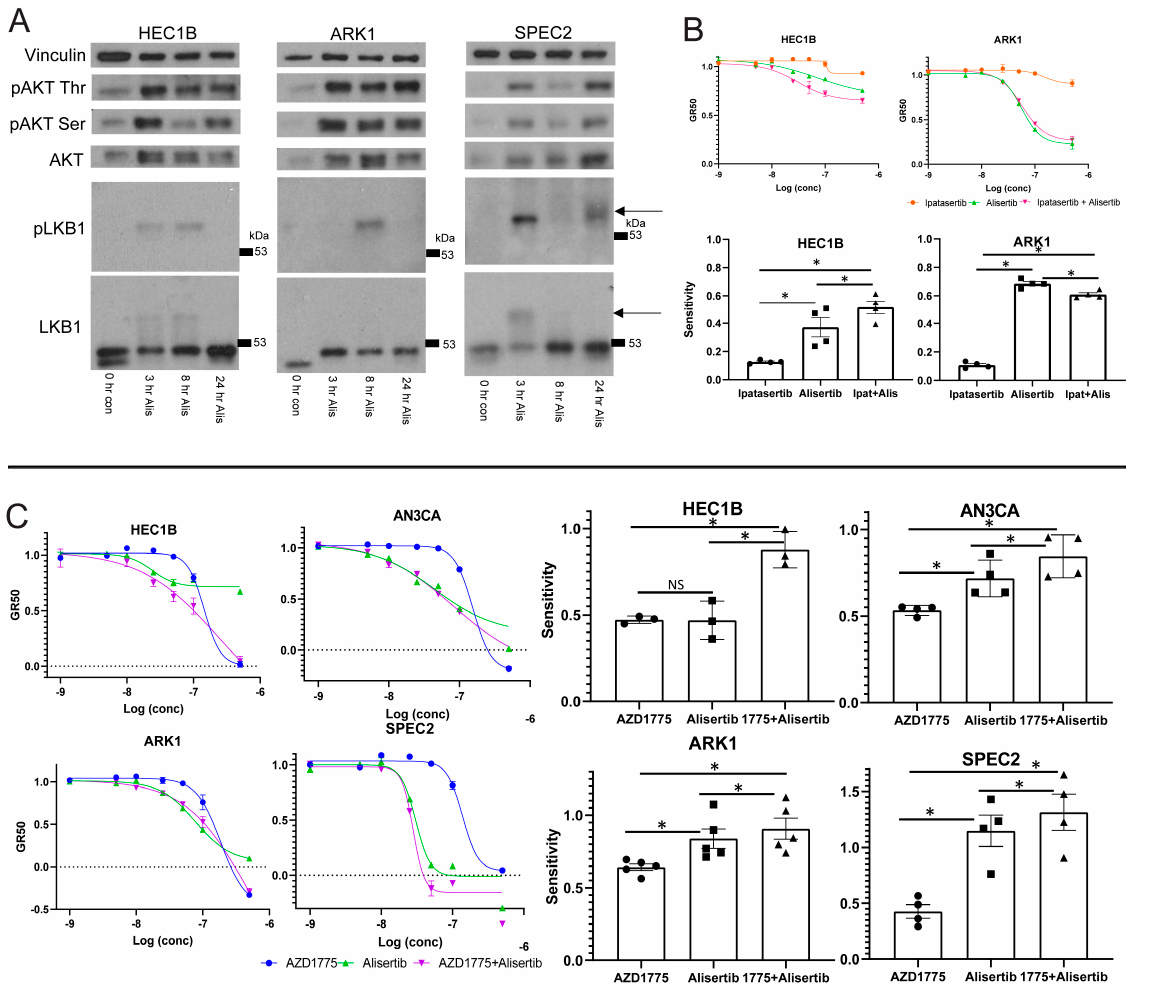
Figure 4. Combining Aurora kinase and WEE1 kinase inhibitors overcomes Aurora kinase inhibitor resistance. ( A ) Cell lines were treated with 0.25 uM Alisertib (Alis) over a 24 h period compared to a 0 h untreated control (con), and lysates were prepared from cells harvested at 3, 8, and 24 h post-treatment and analyzed for LKB1 and AKT expression and modification (AKT phosphorylated on Serine 473 (pAKT Ser) or Threonine 308 (pAKT Thr) and LKB1 phosphorylated on Serine 428 (pLKB1)). In the LKB1 and pLKB1 blots, an arrow indicates the higher molecular weight phosphorylated band. ( B ) An Alisertib resistant (HEC1B) and sensitive (ARK1) cell line was treated with either Alisertib, Ipatasertib, or a combination of Alisertib and Ipatasertib (Ipat + Alis). Representative growth rate corrected dose curves are shown for each line on the left, and sensitivity (area over the growth rate corrected dose curve) is shown on the right for each line with each treatment. Bars represent the average of four replicates, and error bars represent the standard error of the mean. p -values were calculated using both a two-way ANOVA test and a paired t -test comparing different single treatments to the combination or each other. * p < 0.05 for both tests. Comparisons are indicated by a horizontal line over the bars for the treatments being compared (Alisertib vs. Ipatasertib, Alisertib vs. Ipatasertib+Alisertib, and Ipatasertib vs. Ipatasertib+Alisertib). ( C ) An Alisertib resistant (HEC1B) and three sensitive (ARK1, SPEC2, AN3CA) cell lines were treated with either Alisertib, AZD1775, or a combination of Alisertib and AZD1775. Representative growth rate corrected dose curves are shown for each line on the left, and sensitivity (area over the growth rate corrected dose curve) is shown on the right for each line with each treatment. Bars represent the average of three to five replicates, and error bars represent standard error of the mean. p -values were calculated using both a two-way ANOVA test and a paired t -test comparing different single treatments to the combination or each other. * p < 0.05 for both tests. Comparisons are indicated by a horizontal line over the bars for the treatments being compared (Alisertib vs. AZD1775, Alisertib vs. AZD1775+Alisertib, and AZD1775 vs. AZD1775+